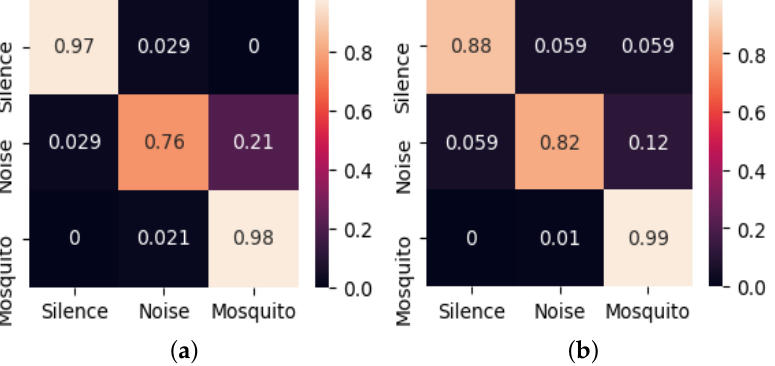
Figure 3. Confusion matrices on PC development platform: ( a ) For validation. ( b ) For